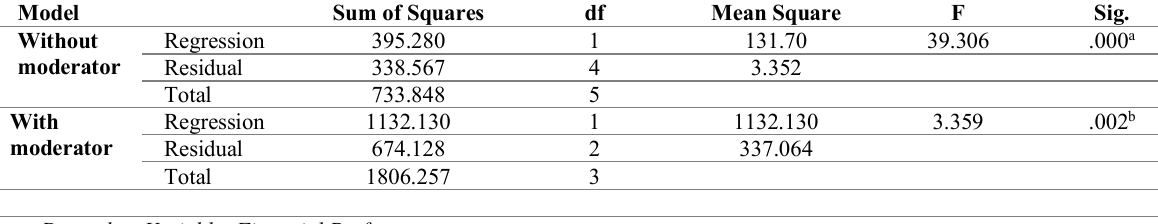
Table 11: Composite ANOVA Summary of Moderating Effect of Ownership Structure